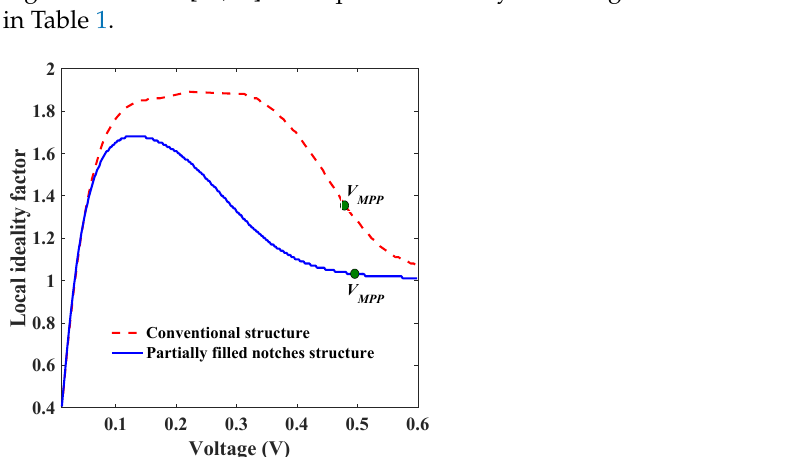
Figure 4. ( a ) A comparison between the dark characteristics of the conventional npn and partially- filled-notches structures and ( b ) equivalent two-diode model. Table 2. Two diode model parameters for the conventional and partially-filled notches microstruc- tures.